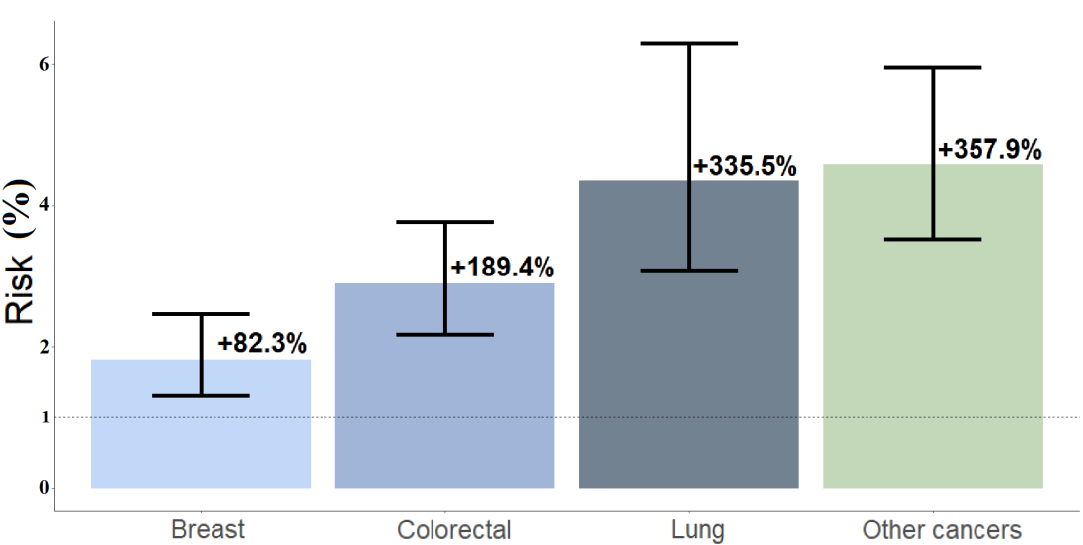
Figure 5. Simulation 2 refers to simulated odds ratios (SORs); percentages are labeled. This was performed for older patients (>75 years old) with bone metastases vs. patients without bone metastases. SORs for lung cancer were 4.35 (95%CI = 3.90 – 6.30); colorectal cancer 2.89 (95%CI = 2.18 – 3.77); other cancers 4.58 (95%CI = 3.53 – 5.95); breast cancer 1.82 (95%CI = 1.32, 2.47).